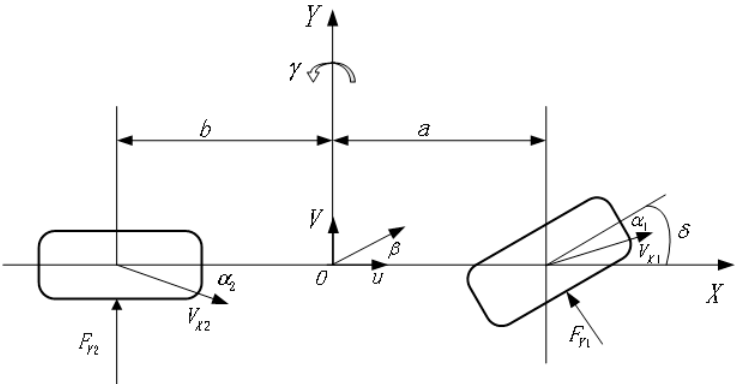
Figure 2. DOF-3 vehicle dynamics model.